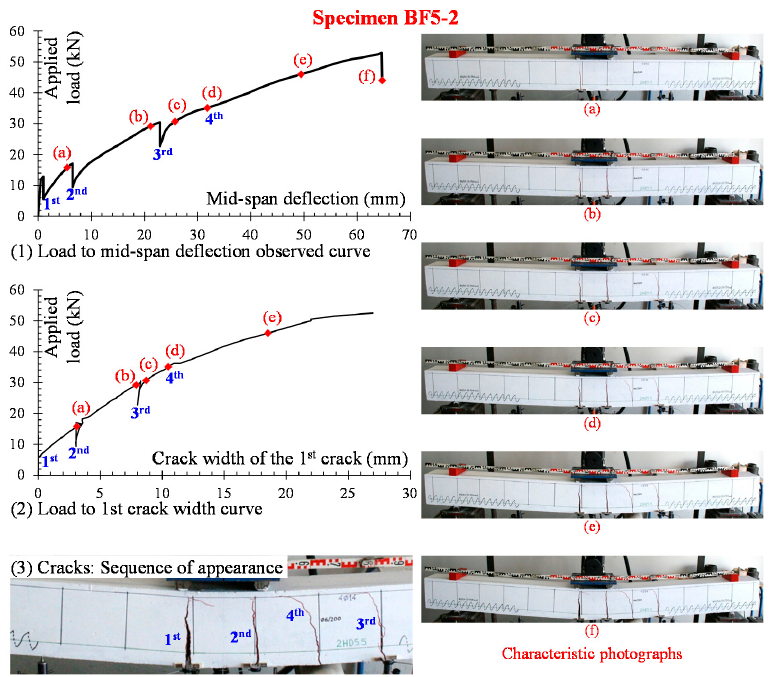
Figure 6. Beam BF5-2. Load to midspan deflection (1) and load to crack width (2) observed curves. Photographs at characteristic points ( a ) to ( f ). Sequence of appearance of the observed cracks (3).